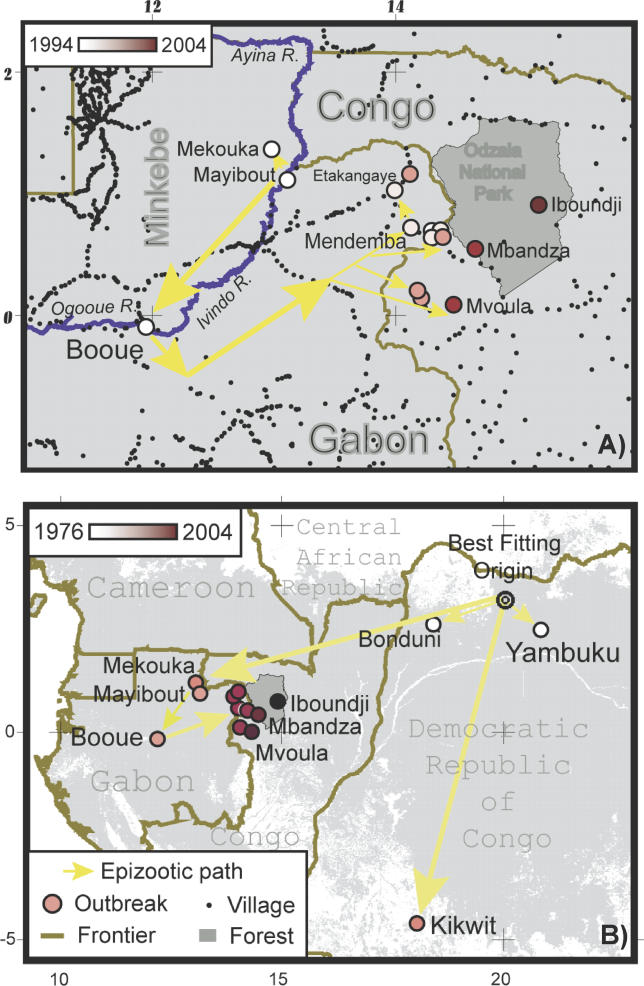
Maps of Ebola Zaire Outbreaks(A) Human outbreak locations in Gabon and Congo as reported [2]. Also shown are October 2003 human outbreak at Mbandza village and April 2004 ape die-off around Iboundji (Lokoué) Clearing in Odzala National Park. Yellow arrows represent epizootic path suggested by phylogenetic analyses.(B) Sites of all primary outbreaks of Ebola Zaire in humans documented [2,14] and the epizootic path suggested by the spatio-temporal pattern of outbreaks (yellow arrows). Best fitting origin found through ML search for the spatial location that produced the strongest correlation between outbreak date and geographic distance from the origin. ML search based on the correlation between patristic genetic distance and spatial separation between outbreaks places the epizootic pivot point just southeast of Booué. In both figures, shading of circles is proportional to time after first outbreak in series.